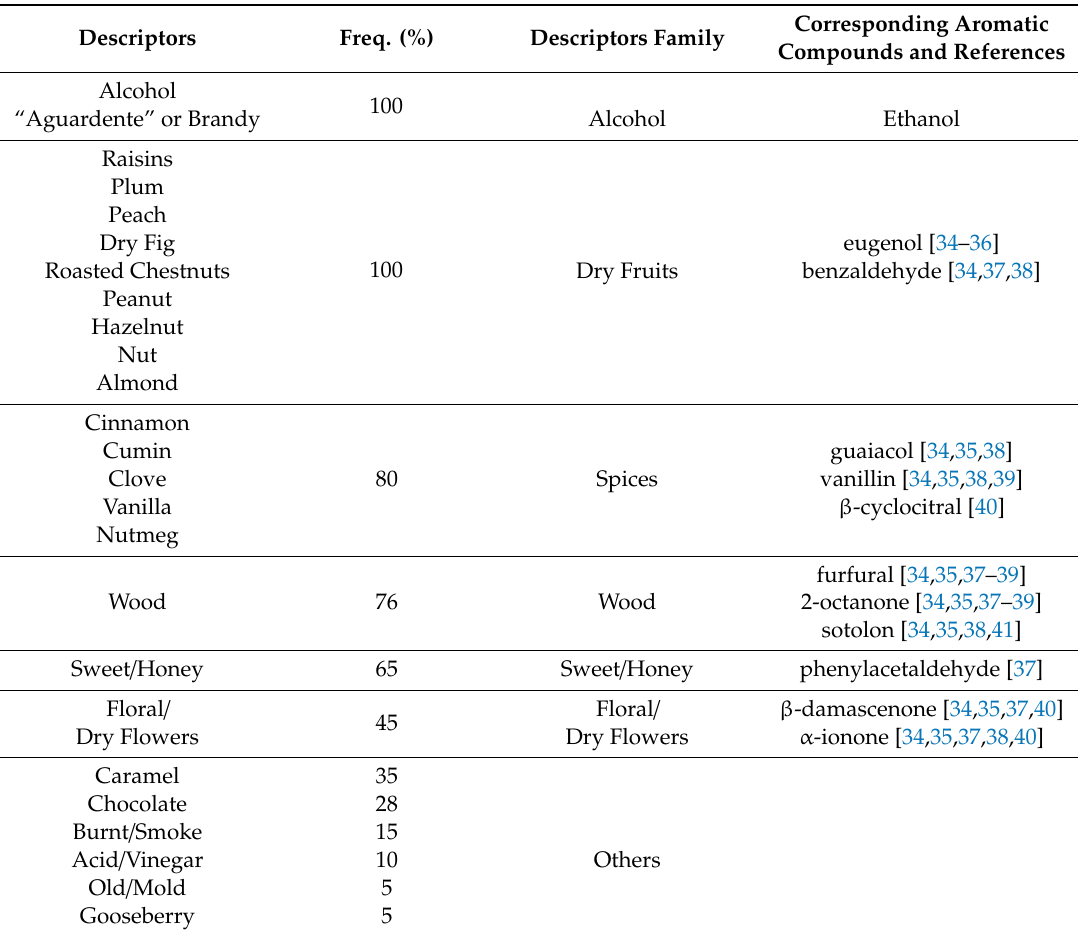
Table 4. Descriptors associated with the four wines’ aromas, their frequency of citation, and corresponding aromatic